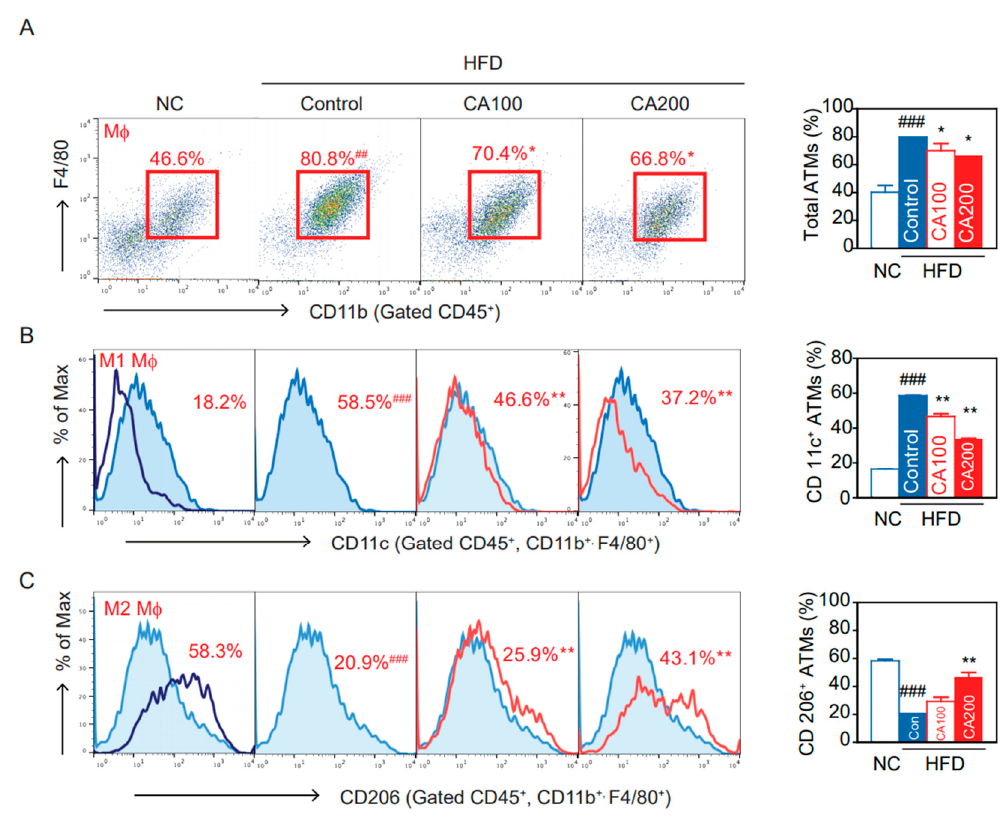
Figure 6. Effects of CA on macrophages and subtypes of adipose tissue macrophages (ATM) in HFD mice: ( A ) flow cytometry of CD45+, CD11b+, and F4/80+ ATM, and percentage of total ATM, ( B ) percentage of CD11c+ inflammatory ATM, and ( C ) percentage of CD206 + anti-inflammatory ATM. Data are expressed as the mean ± SEM ( n = 5). ## p < 0.01, ### p < 0.001 vs. NC, and * p < 0.05, ** p < 0.01 vs. HFD-control. NC, normal chow; Control, HFD-control; CA100, HFD plus CA 100 mg/kg; CA200, HFD plus CA 200 mg/kg.